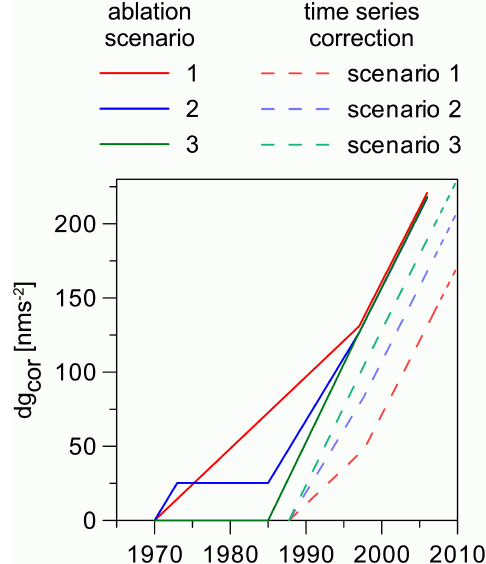
Fig. 5. Gravity effect of glacial ablation based on different ice loss rate scenarios. Solid lines indicate the gravity effect of the glacial ablation model during the entire inventory period, while the dashed lines show the corresponding correction applied on the observed gravity time